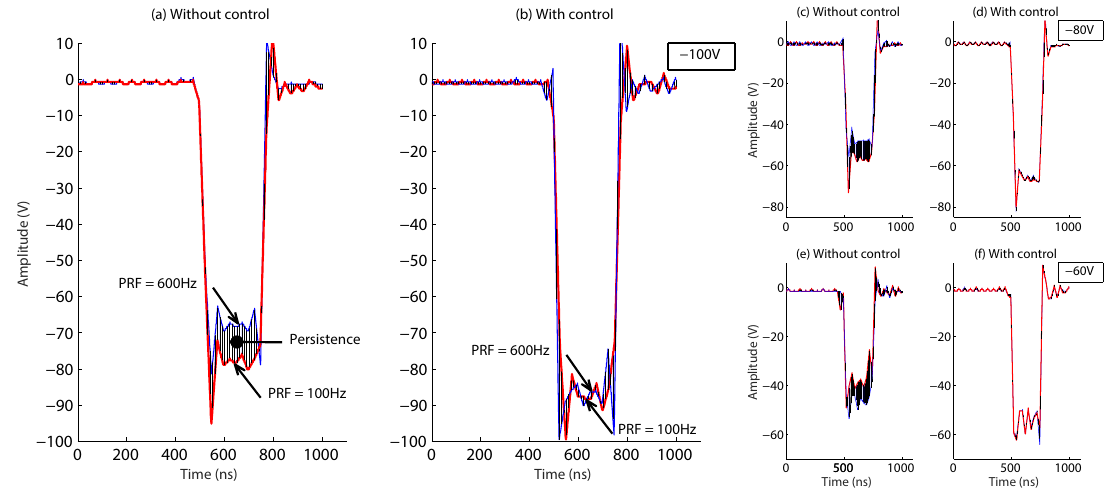
Figure 17. Comparison of the quality of the HV pulse with the proposed control and without the control, for different values of voltage and different frequencies. Set point at − 100 V, ( a ) without control, ( b ) with control. Set point at − 80 V, ( c ) without control, ( d ) with control. Set point at − 60 V, ( e ) without control, ( f ) with